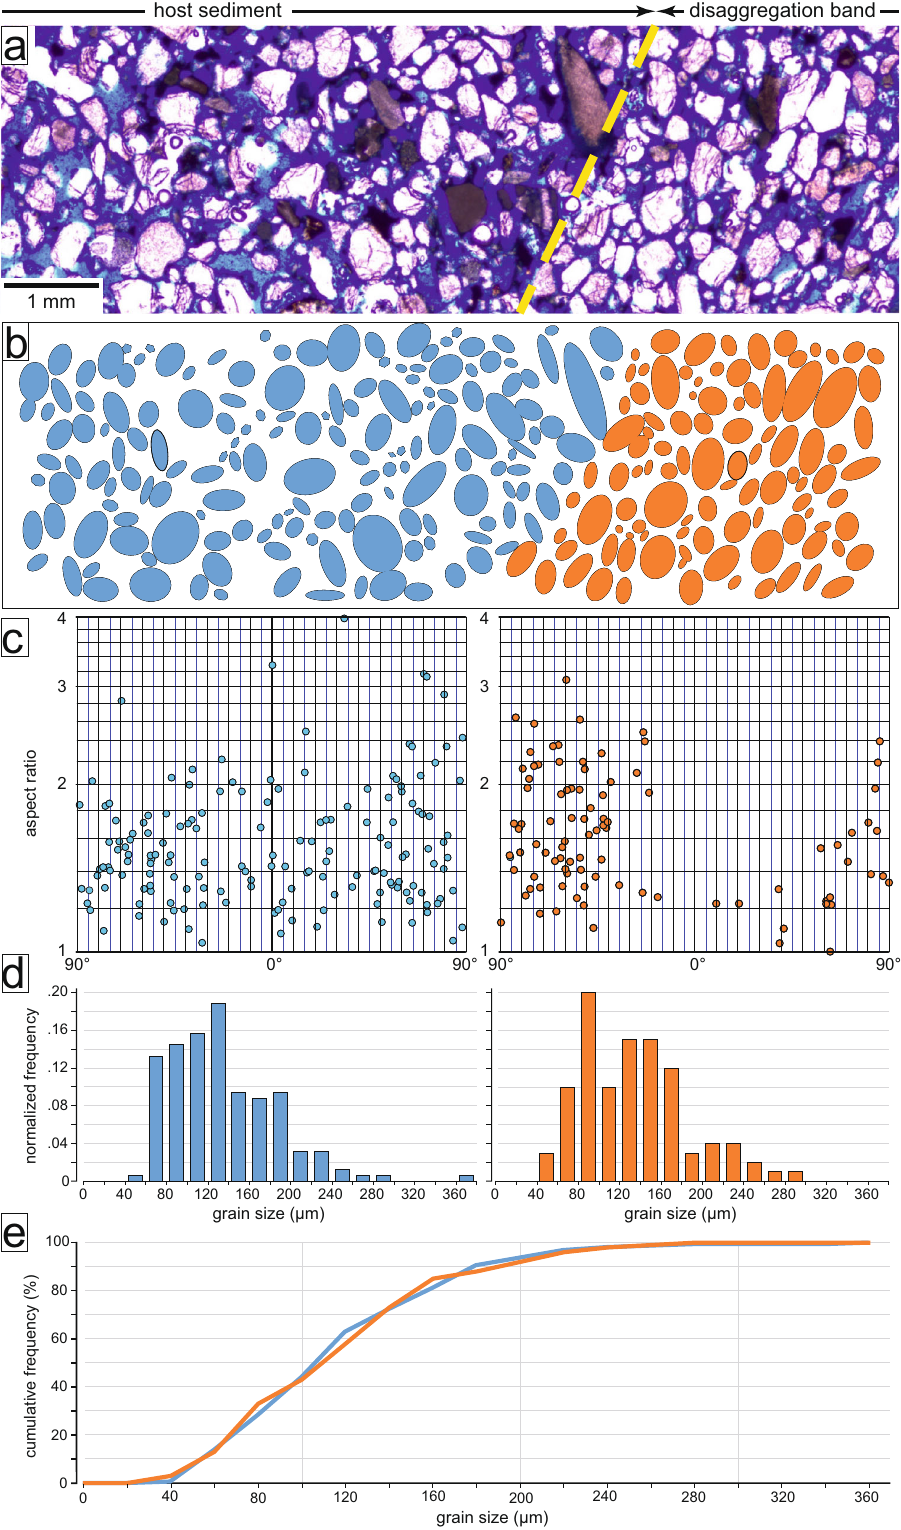
19.5 – 20.5% in the band). The porosity loss in the experimental bands is much lower compared to natural bands, indeed not every experiment showed a clear porosity loss. This is probably caused by the lack of con fi ning pressure. Nevertheless, with our experiments, we are able to reproduce the major characteristics of natural disaggregation bands (Fig.